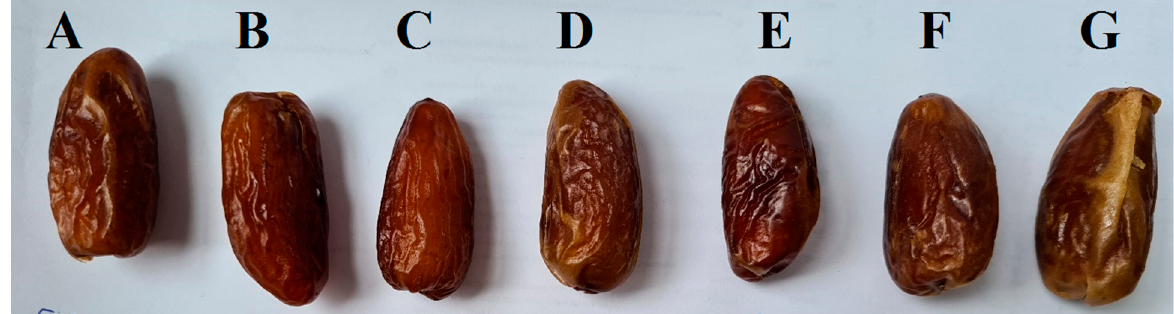
Figure 7. Experiment for maintaining the initial properties of dates after processing and being held for three days in +5 °C. ( A ): no processing; ( B ): 8 MPa silent; ( C ): 12 MPa silent; ( D ): 15 MPa silent; ( E ): 8 MPa, US 800 W; ( F ): 8 MPa, US 1.2 kW; ( G ): 8 MPa, US 1.7 kW.